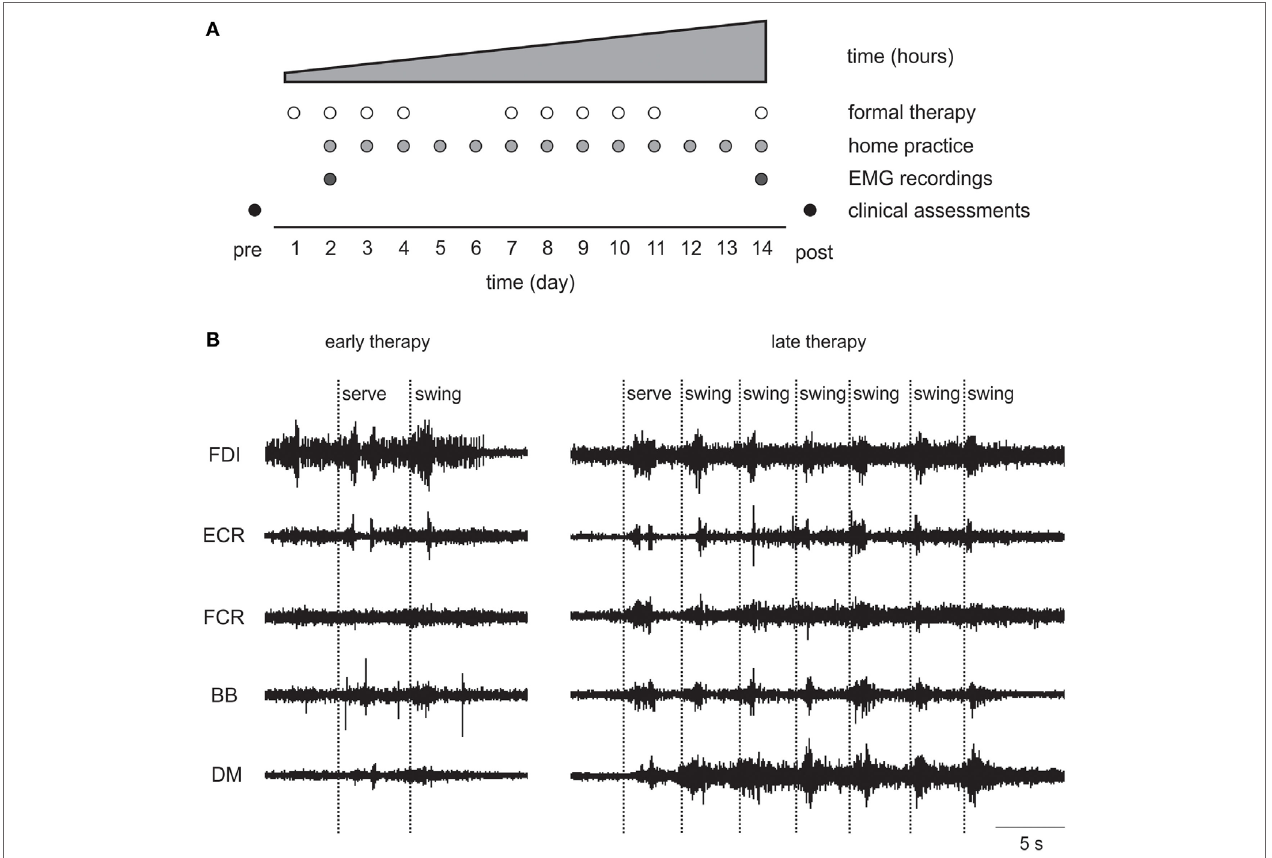
Figure 2 | (a) Wii-based Movement Therapy (WMT) protocol showing electromyography (EMG) recordings on days 2 and 14. (b) Single patient raw EMG at early and late therapy for a 68-year-old female, 46 months poststroke with low motor-function during Wii-tennis. FDI, first dorsal interosseous; ECR, extensor carpi radialis; FCR, flexor carpi radialis; BB, biceps brachii; DM, deltoid